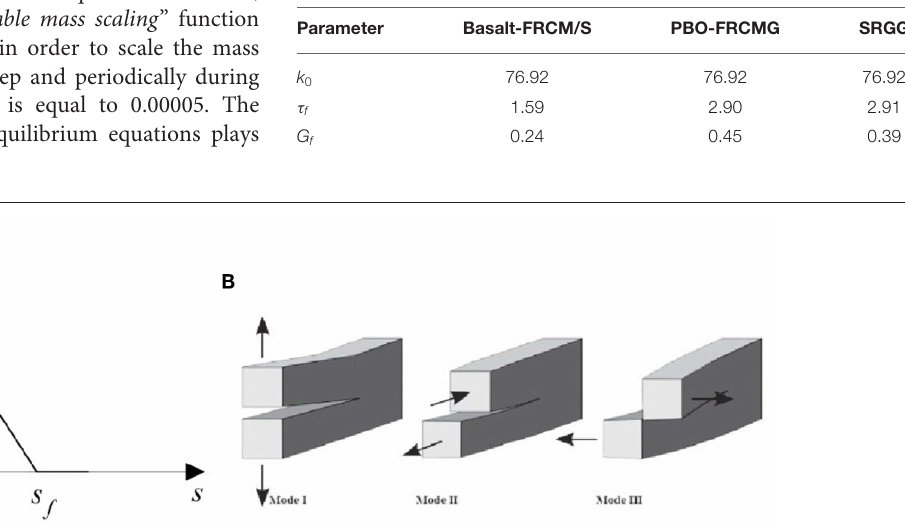
quasi-static application was used. Moreover, the HHT operator is an extension of the Newmark β -method.